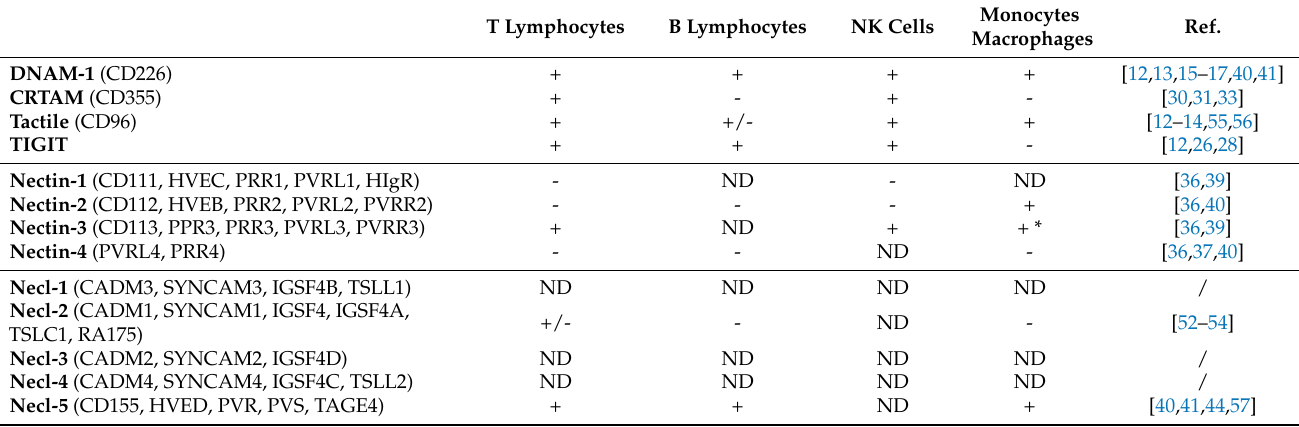
Table 1. Expression profile of Nectin and Necl proteins and their ligands within the healthy immune system. All data are based on protein expression in human peripheral blood mononuclear cells (PBMCs) or NK-92 and Jurkat T-cell lines. Alternative gene nomenclature was extracted from the Na- tional Center for Biotechnology Information (NCBI) and UniProt. CD, cluster of differentiation; HVE, human-herpesvirus entry receptor; PRR/PVRL, poliovirus-receptor-related gene; HIgR, herpesvirus Ig-like receptor; CADM, cell adhesion molecule; SYNCAM, synaptic-cell adhesion molecule; IGSF, immunoglobulin-superfamily gene; TSLL/TSLC, tumor-suppressor gene; TAG, tumor-associated glycoprotein. Monocytes T Lymphocytes B Lymphocytes NK Cells Macrophages